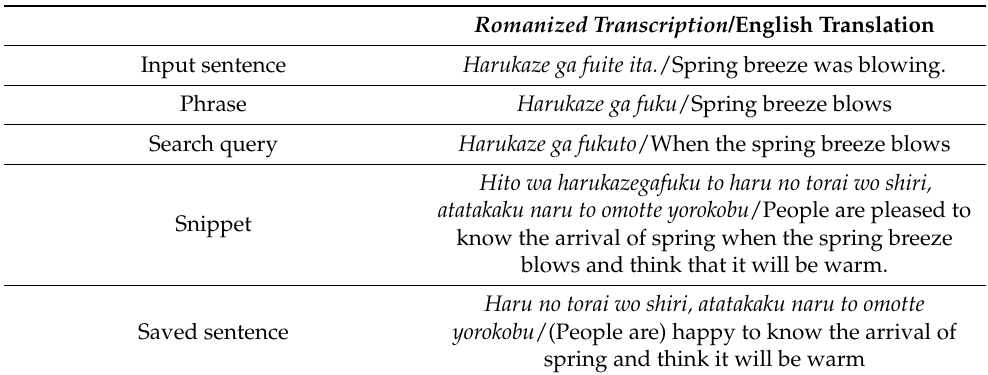
Table 2. Example of inputting Japanese lyrics to saving the sentence to be analyzed when estimating emotions by Web